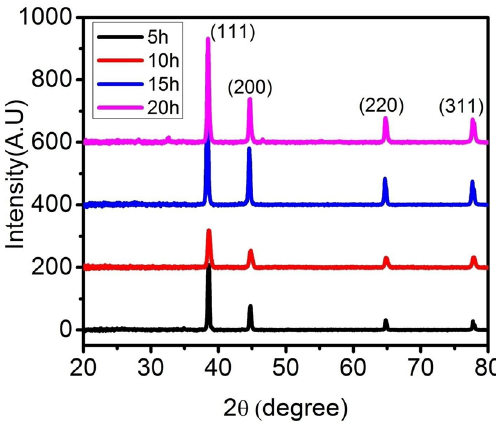
Fig. 1 XRD pattern of Ag/C for different synthesis times obtained at 175 °C temperature. a Ag/C-5, b Ag/C-10, c Ag/C-15, d